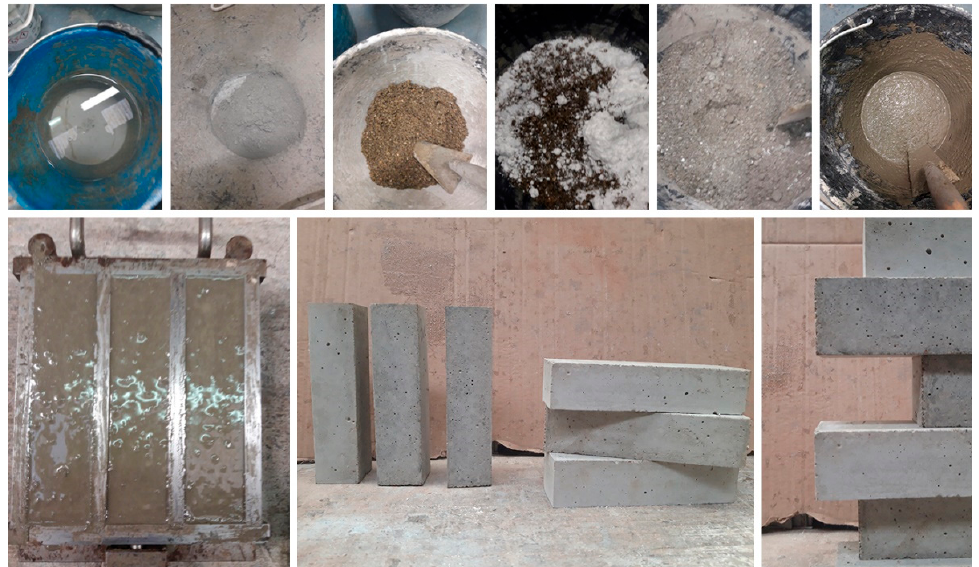
Figure 1. Preparation phase of the specimens ( top ), curing phase and specimens made ( bottom ).